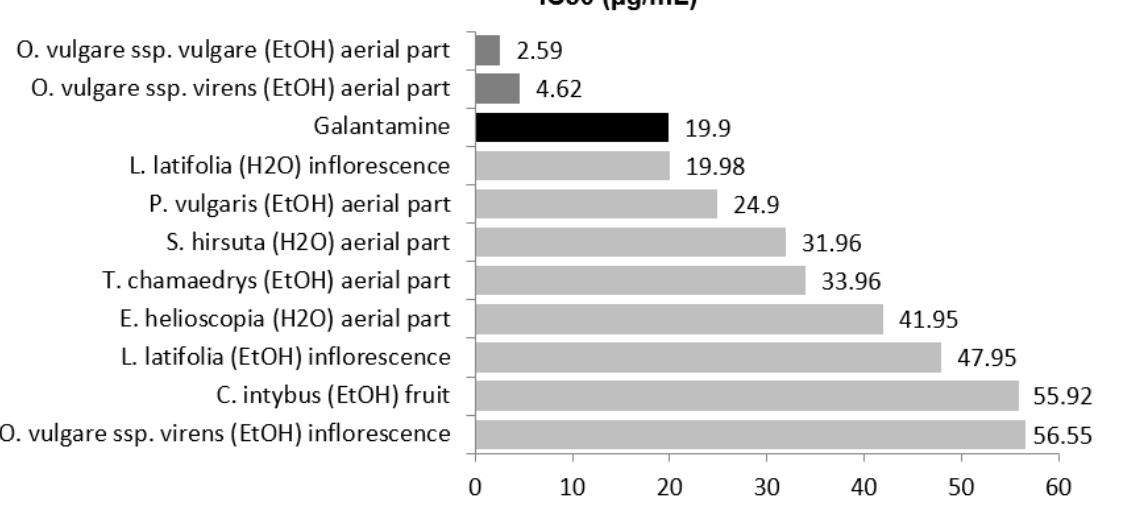
Figure 1. TOP 10 ranking of antioxidant extracts expressed as IC50 (µg/mL) values. Two alcoholic extracts presented higher anti-AChE potency than galantamine (19.9 ± 4.80 µg/mL), aerial parts of O. vulgare ssp. virens (4.62 ± 0.01 µg/mL) and O. vulgare ssp. vulgare (2.59 ± 0.01 µg/mL). The aqueous extract of inflorescence from L. latifolia showed an IC50 value (19.98 ± 0.49 µg/mL) equal to galantamine.